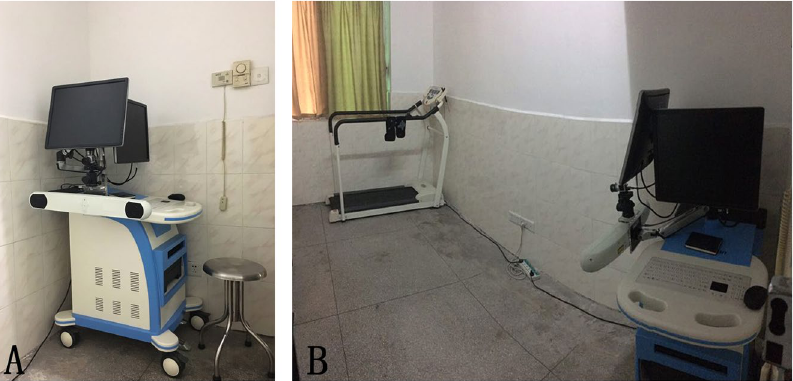
Figure 3. The gait system and the working place. ( A ) The gait analysis machine has about an area of 0.8 m × 0.8 m × 1.5 m. ( B ) The working place is located in the hospital near the doctors’ office for the doctors to test